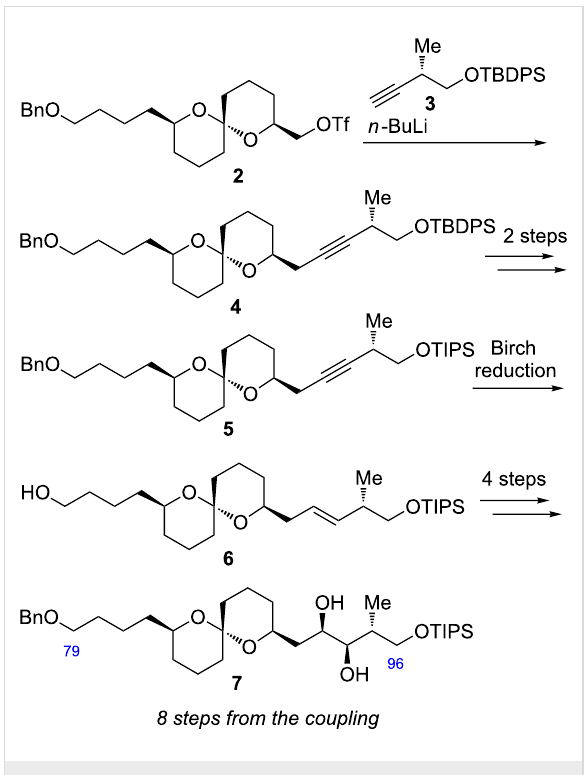
Scheme 1: Our previous synthesis of the C79–C96 fragment 7